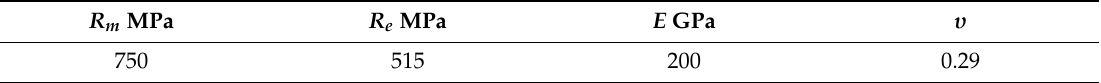
Figure 2. Mertens–Dittmann ( a ) and Seeger–Bestea ( b ) transformation based on [17].